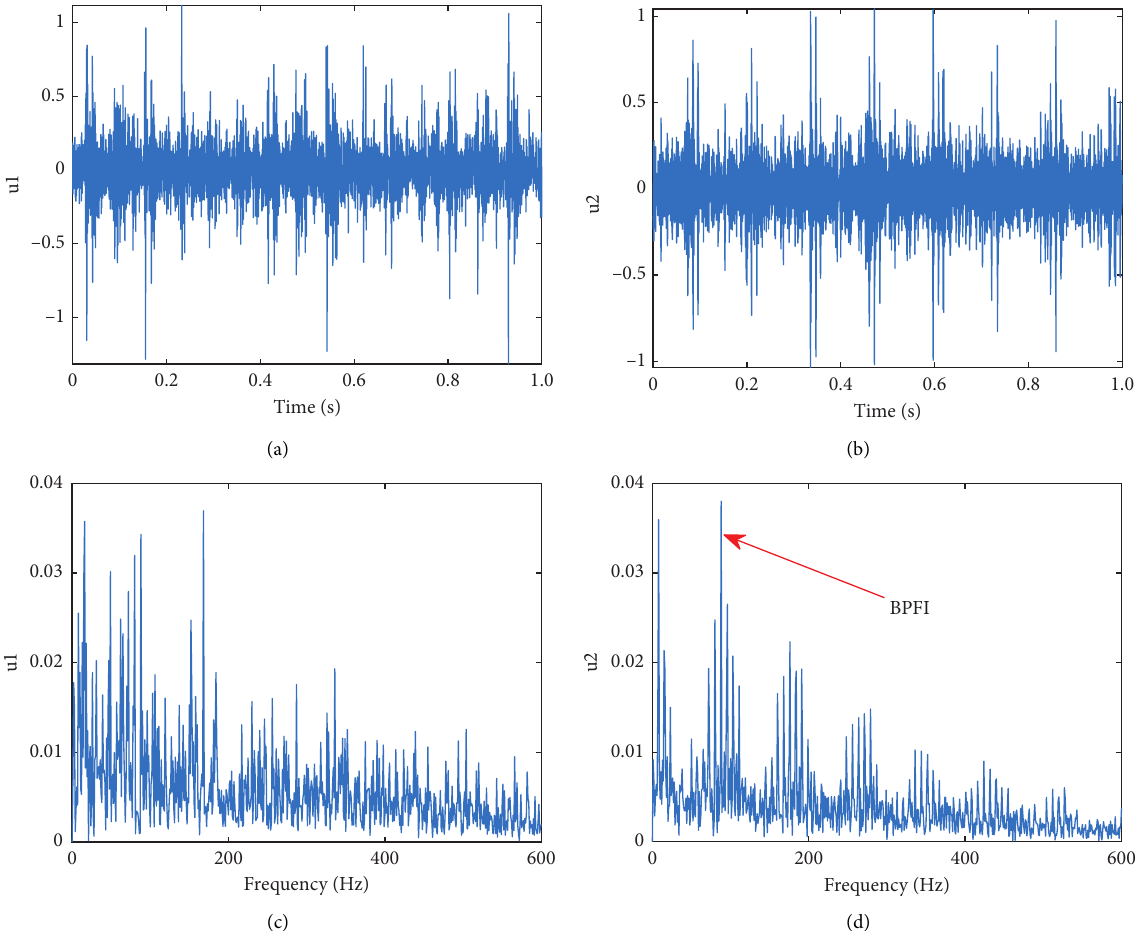
Figure 32: Experimental signals of case 2: signal processing results based on PAVMD: (a, b) time-domain waveform of each mode and (c, d) the corresponding squared envelope